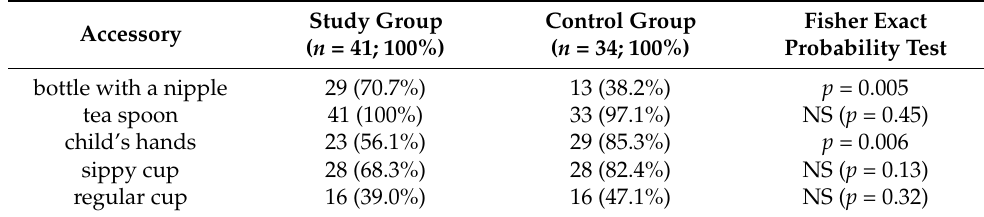
Table 9. Accessories used while feeding the child in the study group and the control group (question I/12).